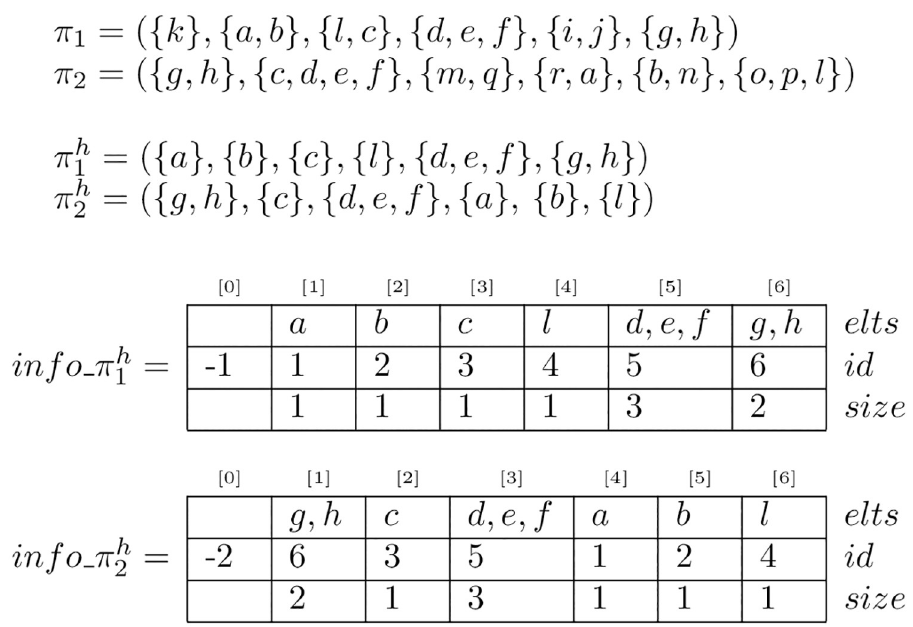
Fig 3. Example of computation of LCIS using LIS with π 1 and π 2 . The LIS of the sequence of identifiers from ½ 1 � , (6, 3, 5, 1, 2, 4), is (1, 2, 4) and gives the LCIS of π 1 and π 2 : ( a , b , l info p h 2